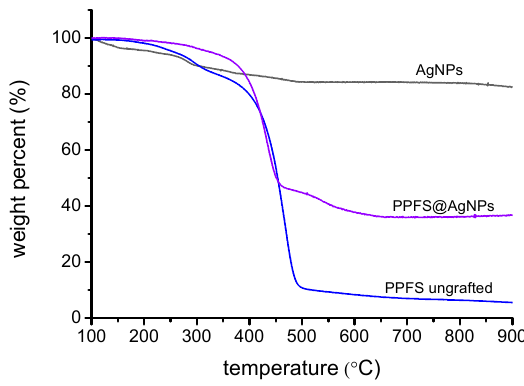
Figure 4. TGA analysis of bare AgNP, RAFT generated DA-DCMA coupled PPFS chains, and PPFS coupled to AgNPs (PPFS@AgNPs).